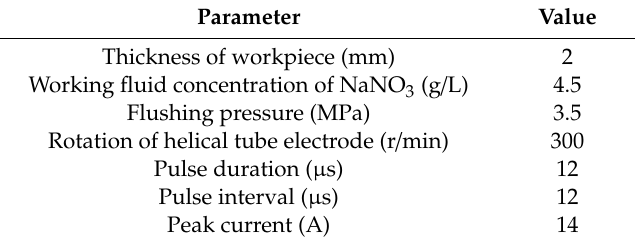
Table 2. Parameters of hole machining for different tube electrodes.